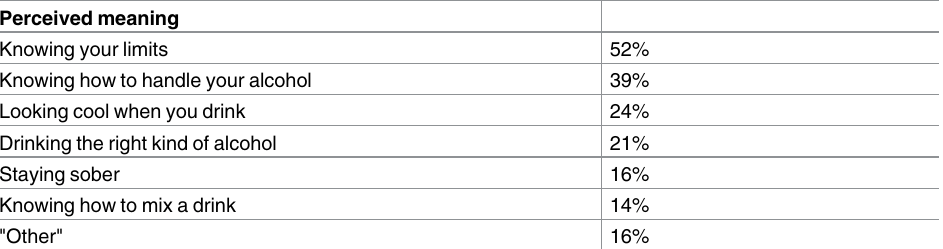
Table 3. Perceived meaning of ‘drink properly’ (Study One, n =